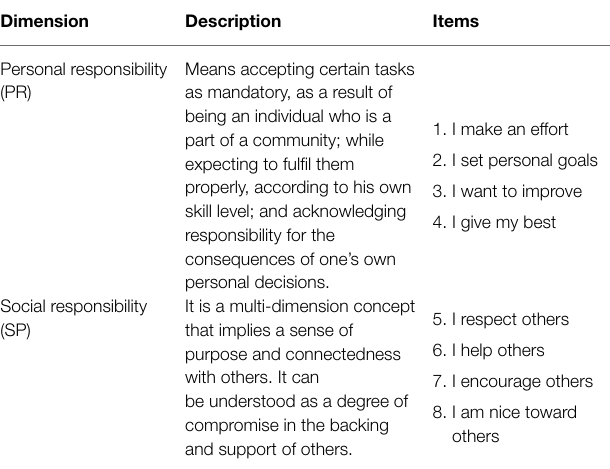
TABLE 3 | Mean, standard deviation and internal consistency of the PSRQ. Dimensions